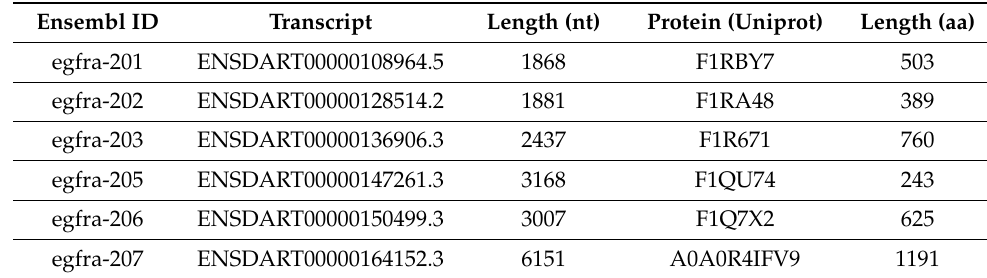
Table 1. List of zebrafish EGFR isoforms in the Ensembl database. ID, transcript name, tran- script length, protein name and protein length for all zebrafish EGFR isoforms listed in the En- sembl database.